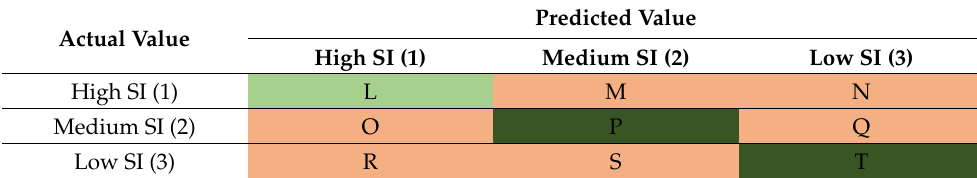
Table 3. Confusion matrix with three